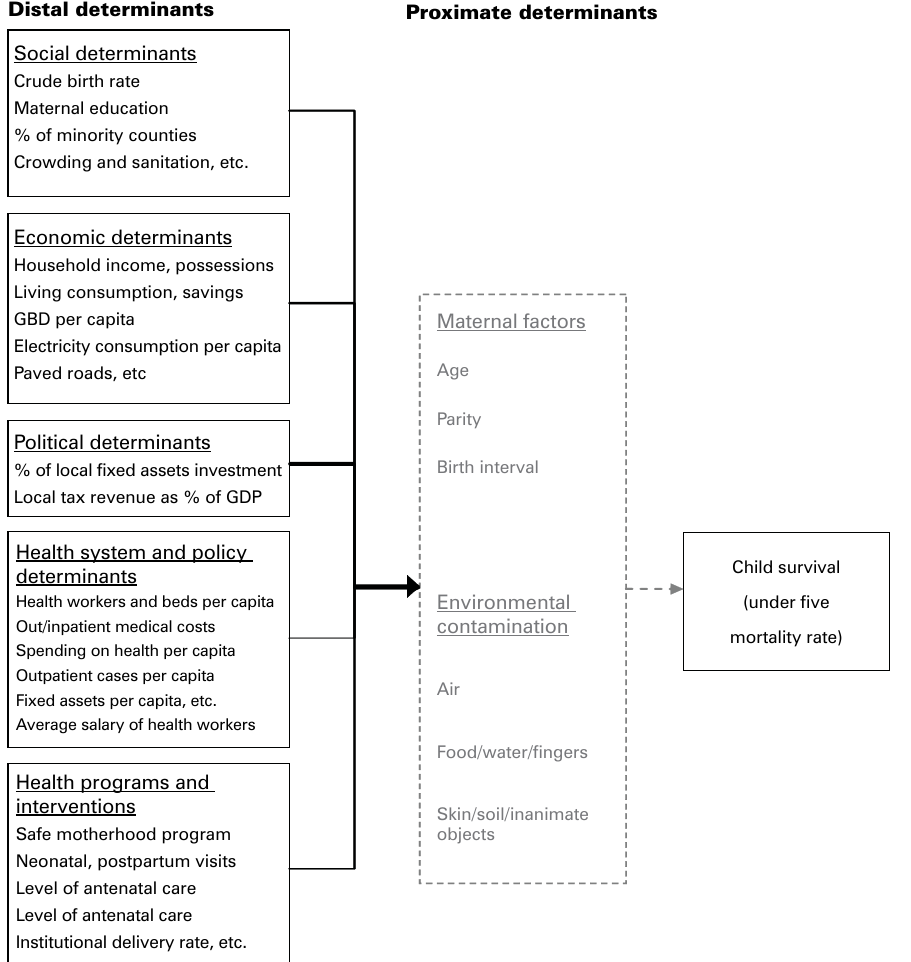
Figure 1 Conceptual framework of social, economic, political, and health system determinants of child survival. Adapted from Mosley and Chen